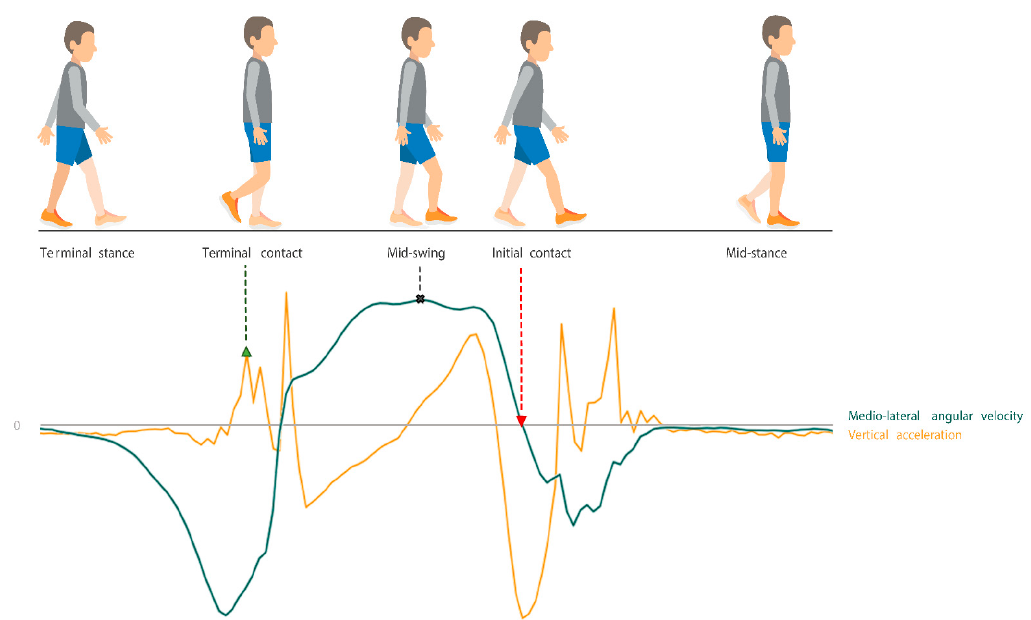
Figure 2. Stride identification was performed based on the filtered mediolateral angular velocity (green graph) and vertical free-acceleration (orange graph) signal features of the foot sensors. Terminal contact was determined at the local peak in vertical acceleration (green triangle pointing up), mid-swing at the peak in medio-lateral angular velocity (cross), and initial contact at zero-crossing of the medio-lateral angular velocity (red triangle pointing down).